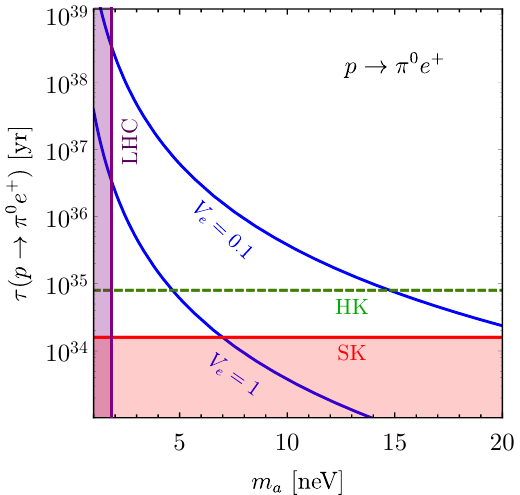
Figure 4 . Predictions for the proton lifetime from the decay channel p shows the Super-Kamiokande constraints, (cid:28) ( p dashed line shows the Hyper-Kamiokande collaboration projected bound, (cid:28) ( p years [44]. The region shaded in purple is ruled out by the collider constraints on the (cid:8) 1 (cid:12)eld, M (cid:8) > 1 TeV 1